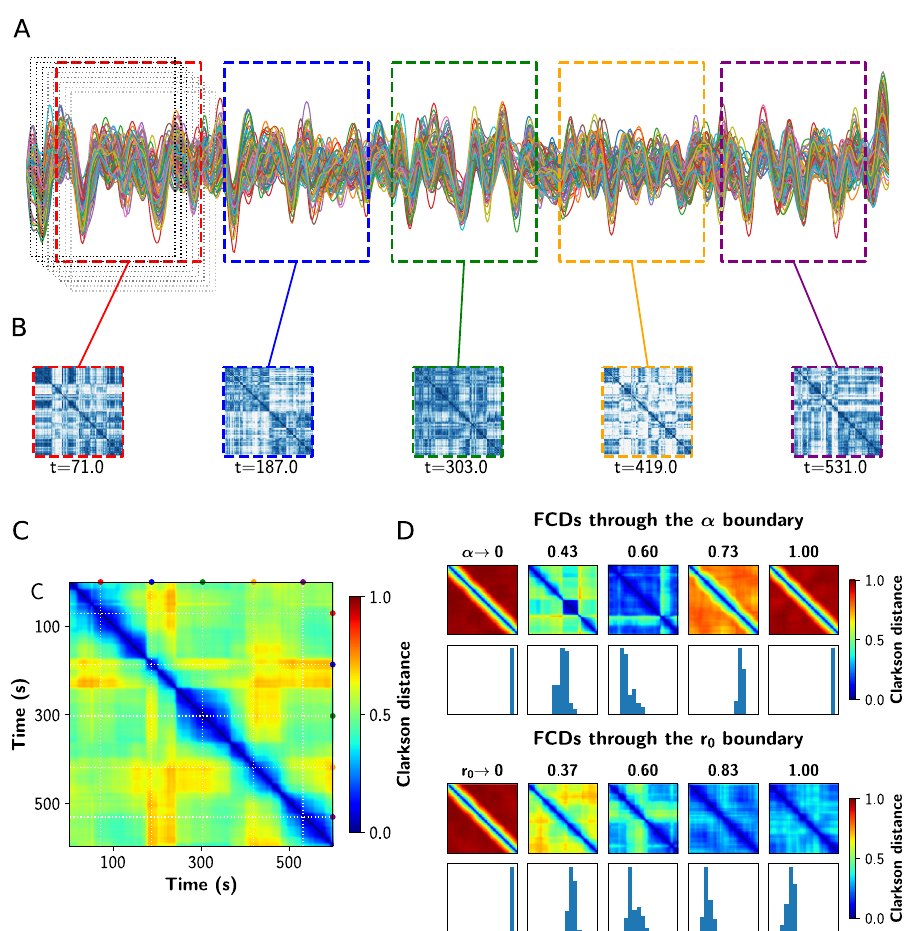
Fig 6. Analysis of functional connectivity dynamics. A) Sample fMRI BOLD time series showing the fixed length and overlapping time windows at the begginging. In color, the time windows corresponding to the FCs shown in B. B) FC matrices obtained in the colored time windows. C) Functional Connectivity Dynamics (FCD) matrix, where all the FCs obtained were vectorized and then compared against each other using a vector-based distance (Clarkson distance). D) FCD matrices through the critical boundary, in both α and r 0 direction. Below each FCD, a histogram of its upper triangular values is shown. The variance of these values constitutes a measure of multistability.